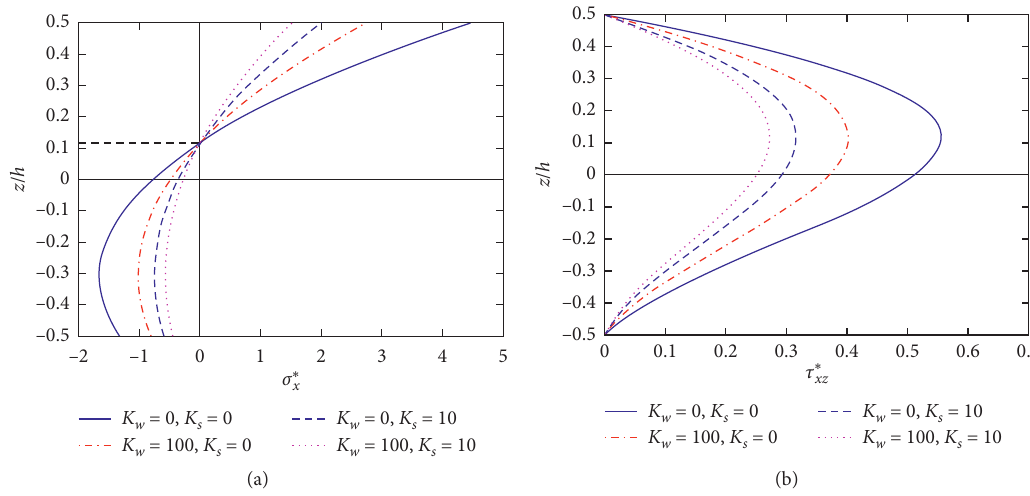
Figure 9: The influence of two parameters of the elastic foundations on the distribution of the stresses with a/h � 10, p �